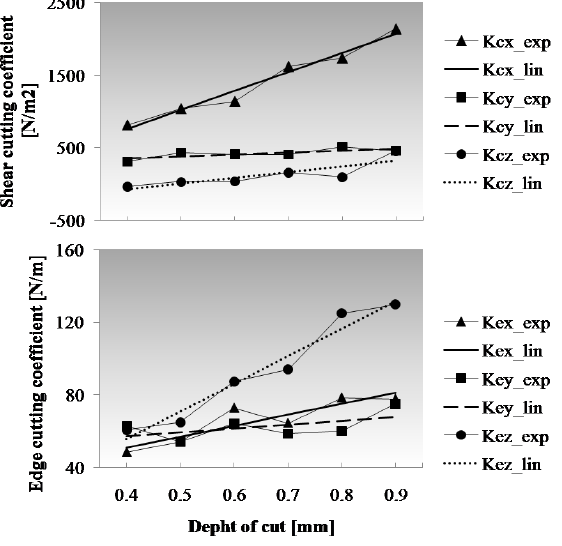
Figure 5: Experimental linearized cutting coeflcients: shear cutting coeflcients (up) in [N/m] and edge coeflcients (down) in [N].